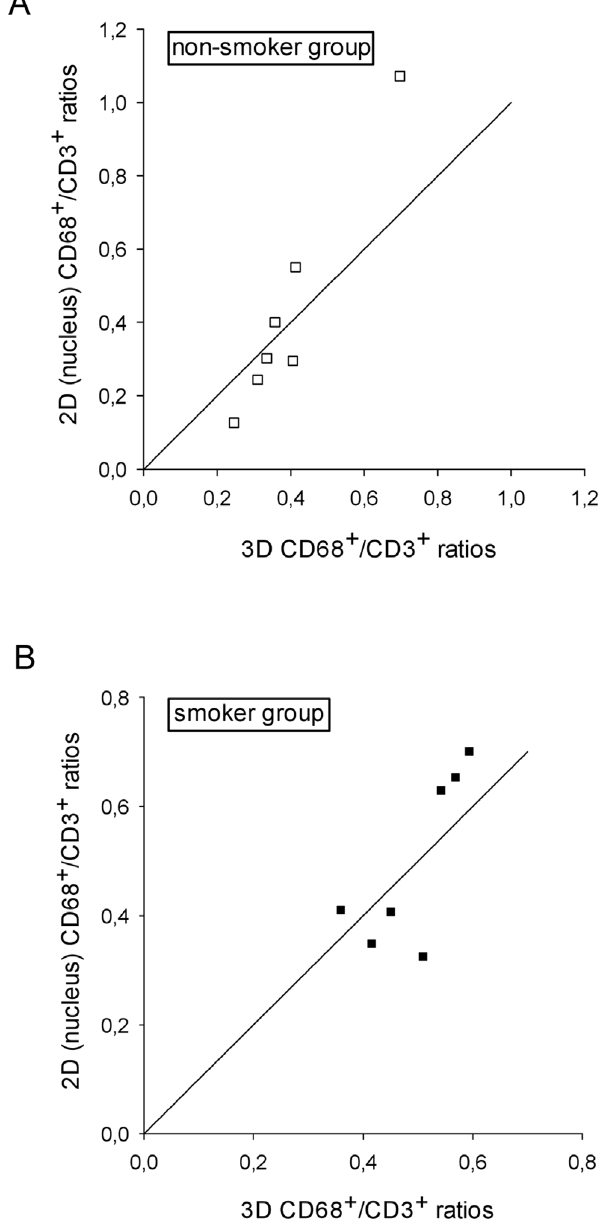
Figure 6. CD68 + /CD3 + cell density ratios estimated by the 2D (nucleus) and 3D design for the non-smoker, r=0.97, p , 0.001 (a) and smoker, r=0.77, p , 0.05 (b) group with the line of equality (y=x).